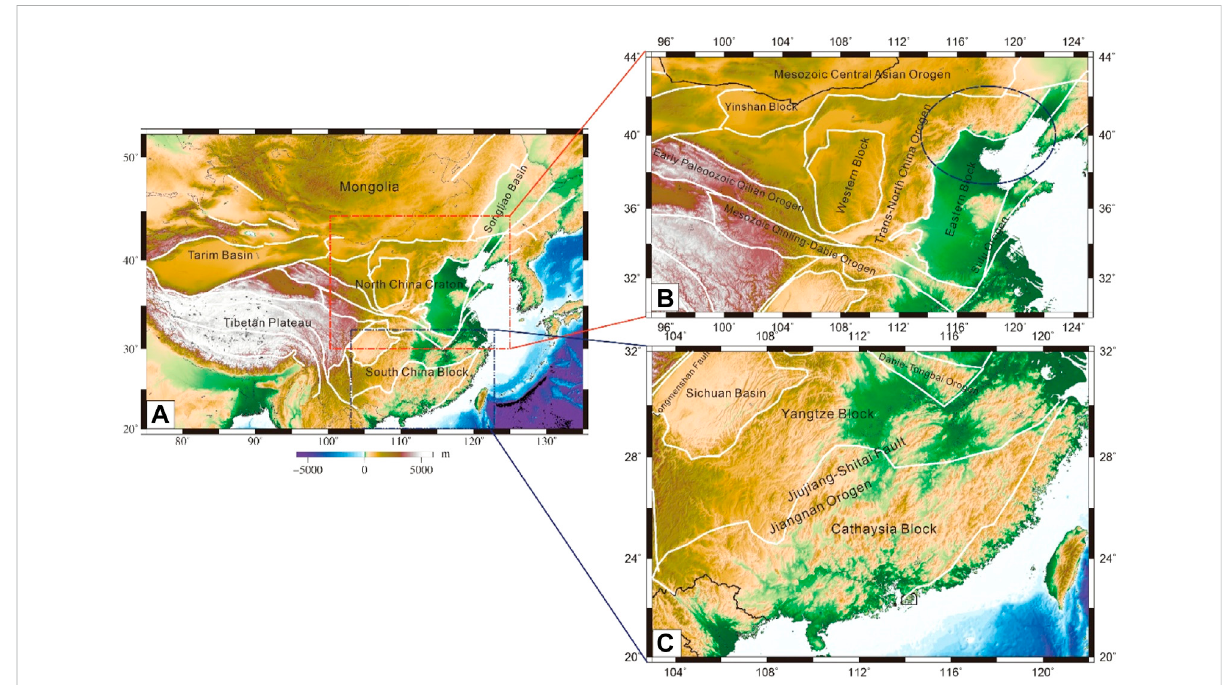
FIGURE 1 The location of the study region (A) : left panel. Red rectangle: North China Block (Craton). Blue rectangle: South China Block. Upper fi gure of rightpanel (B) :thetectonicformworkoftheNCC.Lower fi gureofrightpanel (C) :thetectonicformworkoftheSCB.Whitelines:tectonicboundaries. Oval region: the gold mineral